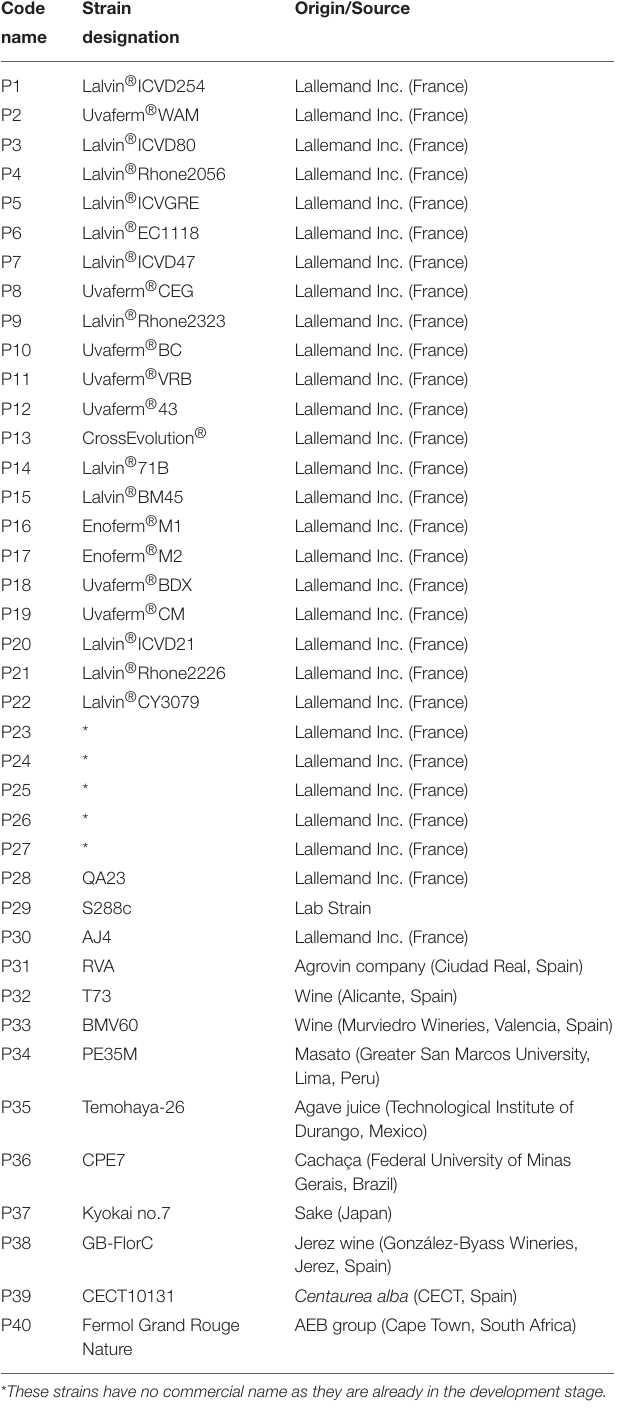
TABLE 1 | The Saccharomyces cerevisiae strains used in this